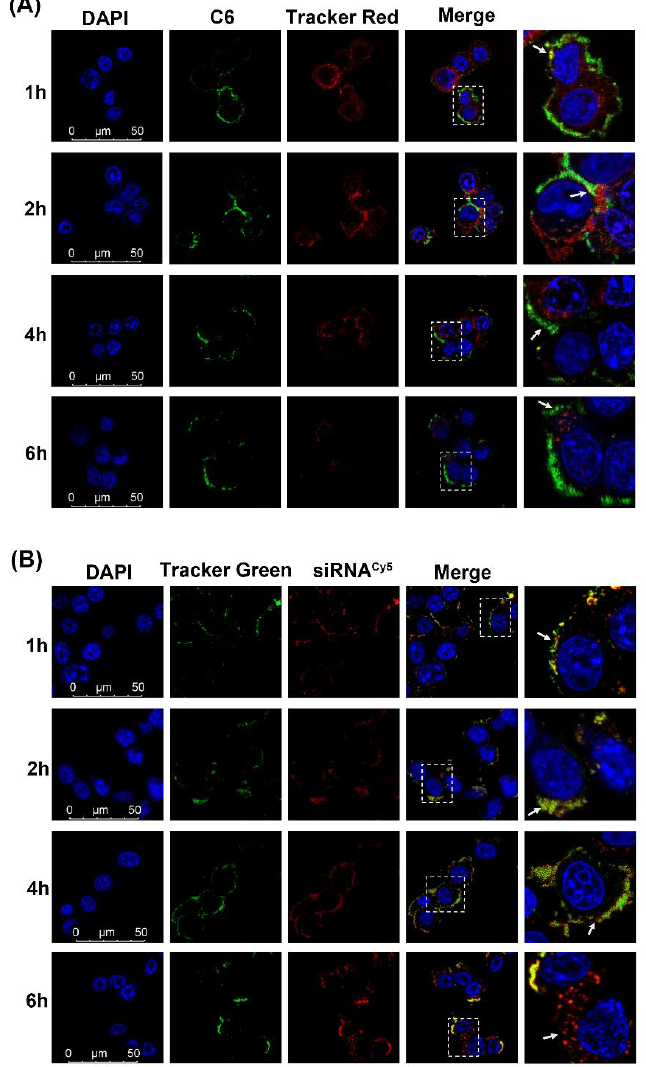
Figure 5. Endosomal escape of C6-siRNA VEGF -NPs ( A ) and Cy5 siRNA-ITZ NPs ( B ) in 4T1 cells undergoing 1, 2, 4 and 6 h, respectively. In order to reduce the ITZ influence, the concentration of ITZ is as low as 1 nM. DAPI for nuclei staining (blue), C6 (green), Cy5 siRNA (red), LysoTracker Red (Tracker Red) and LysoTracker Green (Tracker Green) for endosomes (red and green) were recorded. Scale bar = 50 µm.